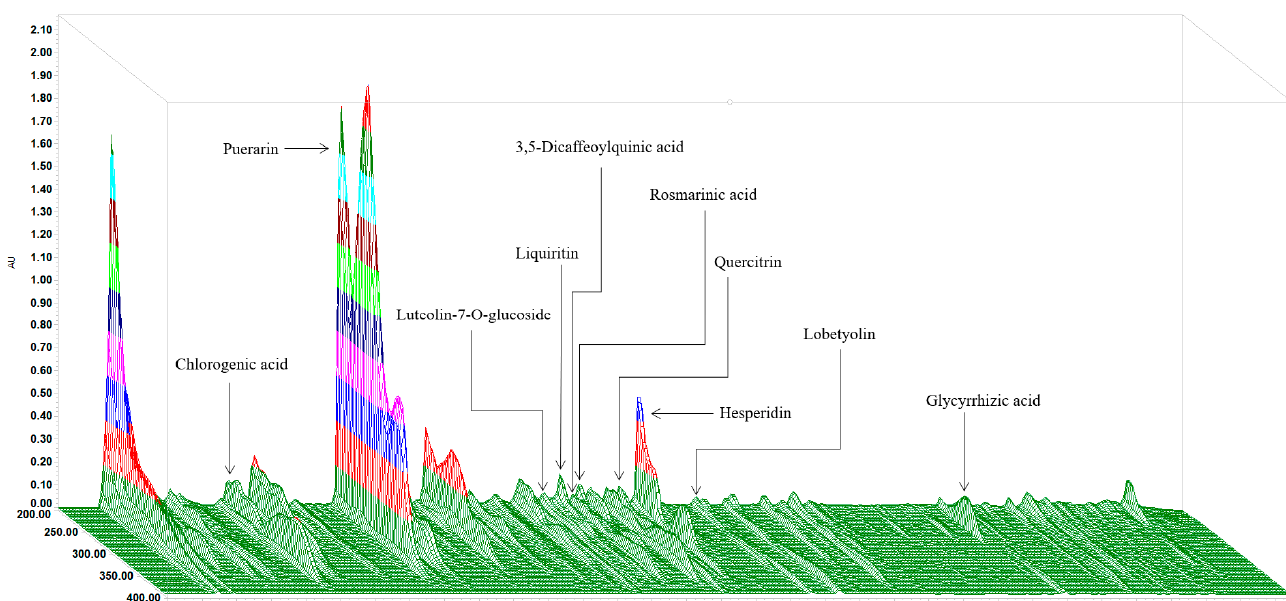
Figure 1. Chemical structure of the active ingredients of the PAFYY.